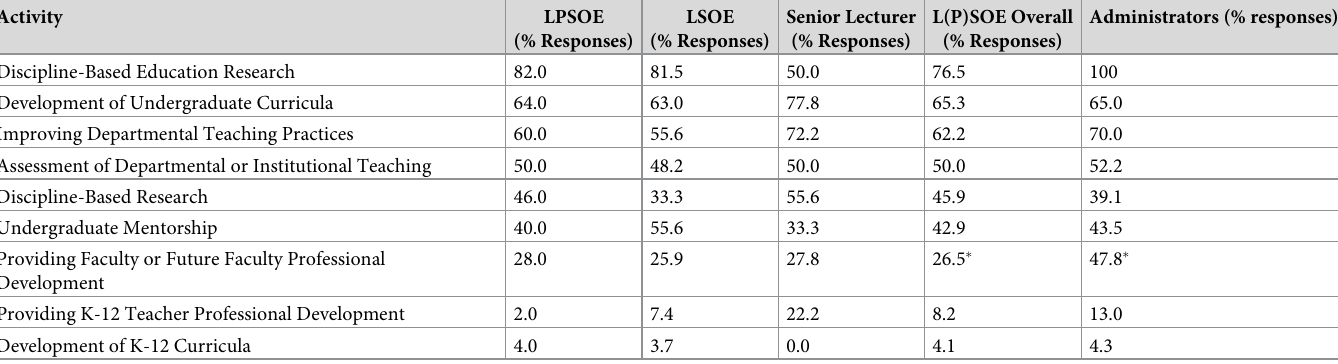
Table 4. L(P)SOE faculty perception of acceptable scholarly activities.